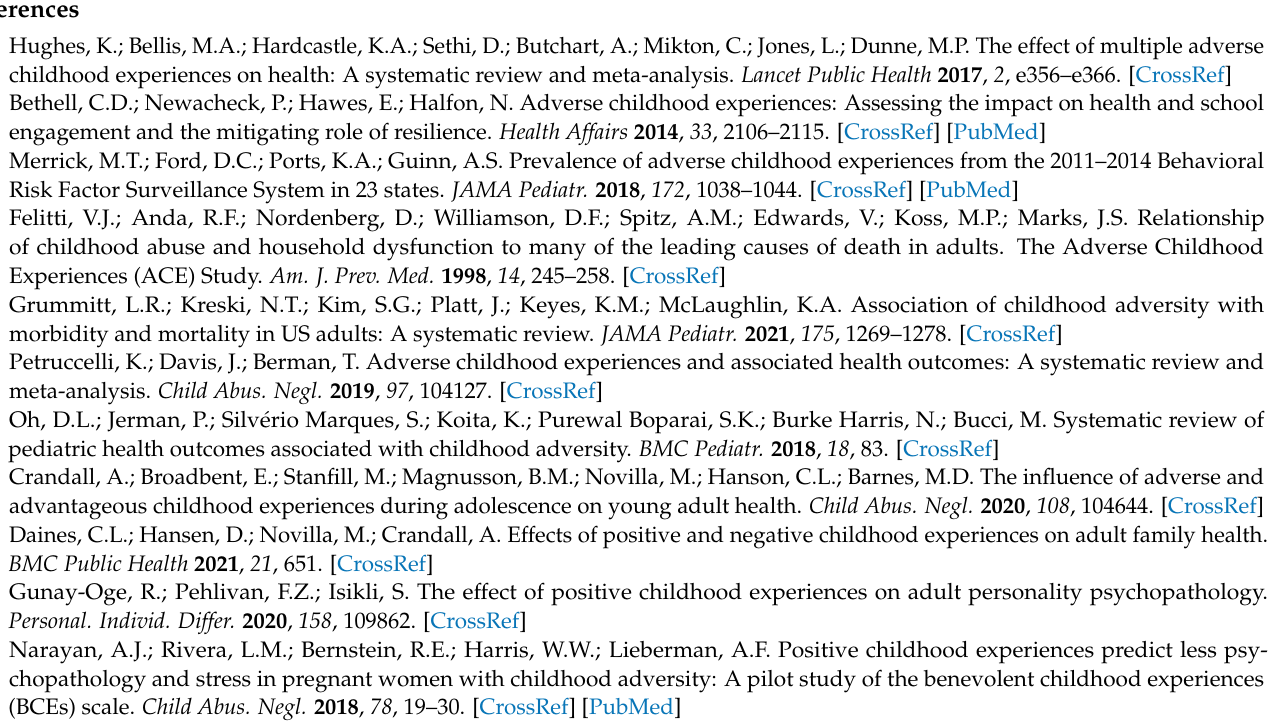
Table S2: Evaluations of psychometric properties of the Chinese version of Positive Childhood Experiences (C-PCEs) 9-item measure; Figure S1: Scree plot for the Chinese version of Positive Childhood Experiences (C-PCEs) 9-item measure; Figure S2: Factor plot in rotated factor space using Promax rotation for the Chinese version of Positive Childhood Experiences (C-PCEs) 9-item